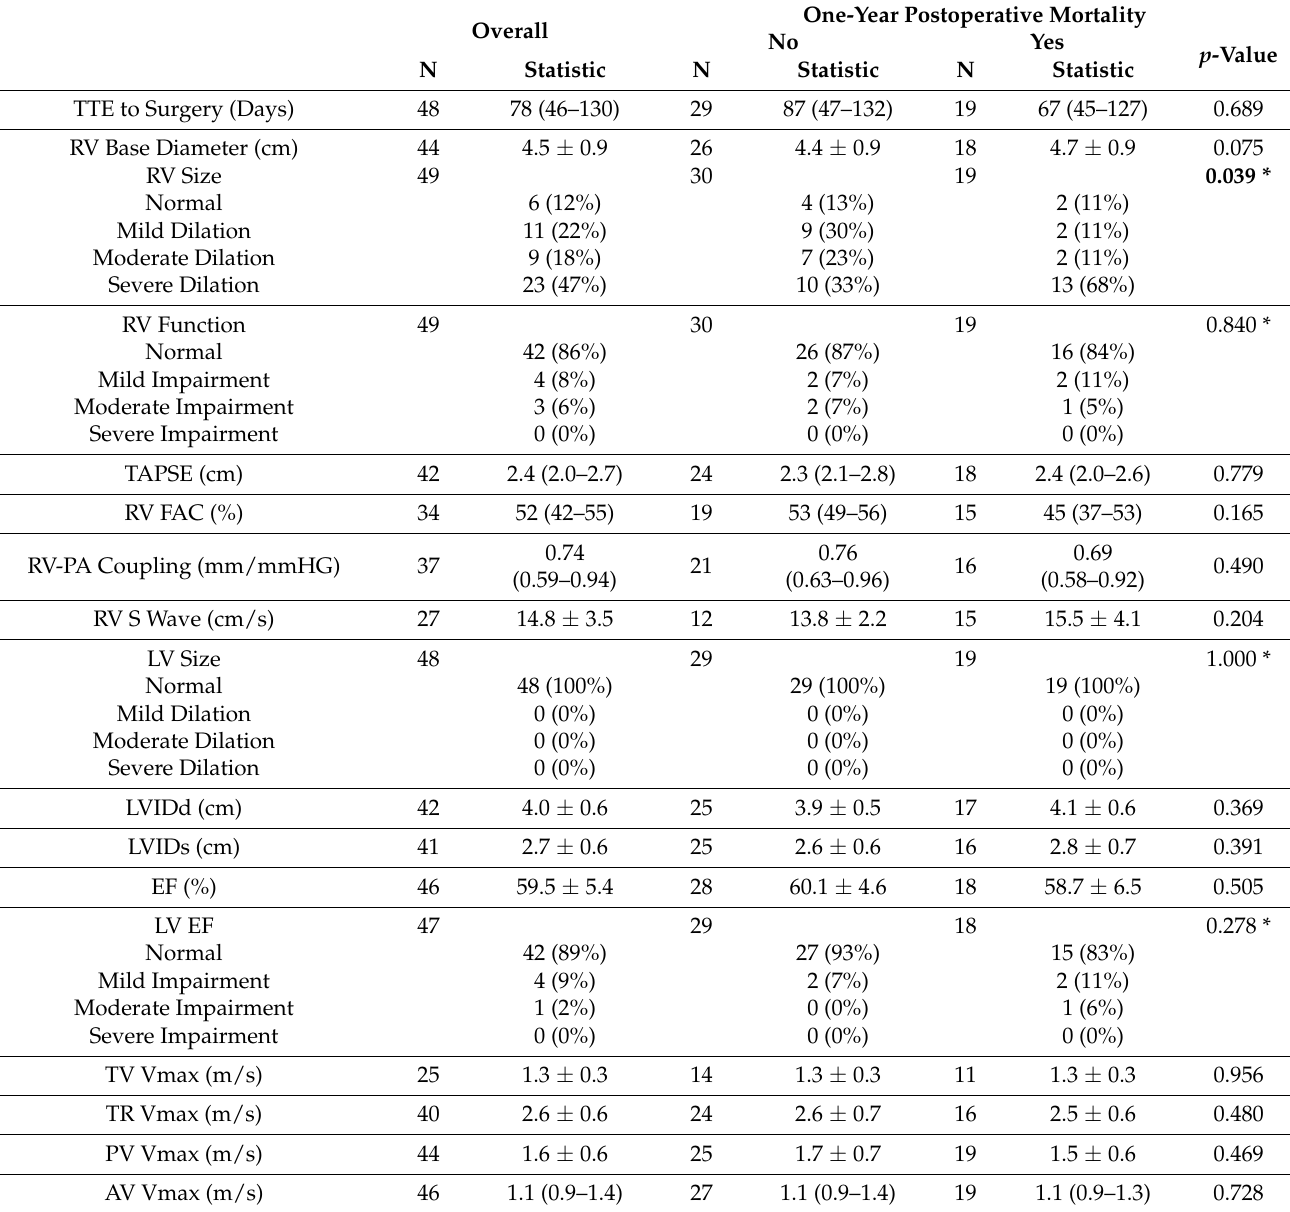
Table 2. Association Between Preoperative Echocardiography and One-Year Mortality.